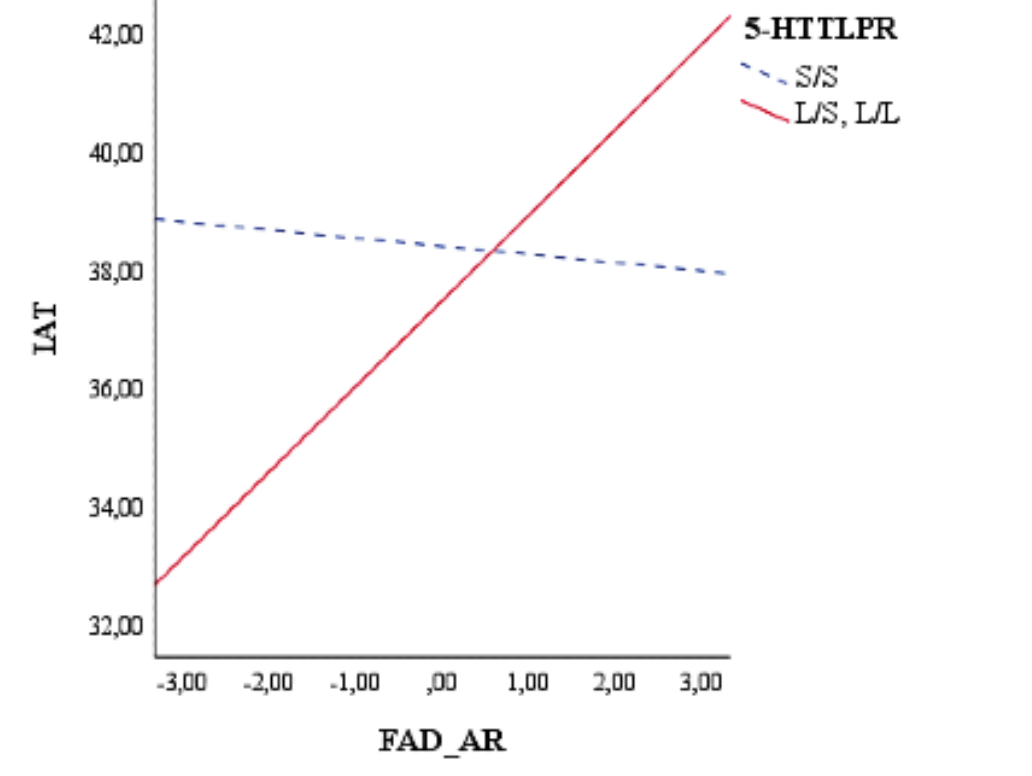
Figure 4. Moderation of youth’s 5-HTTLPR genotype on the relationship between the youth’s family functioning and IAT score. 5 ‐ HTTLPR: Serotonin-transporter linked polymorphic region; FAD_AR: Family Assessment Device Affective Responsiveness; IAT: internet addiction test.